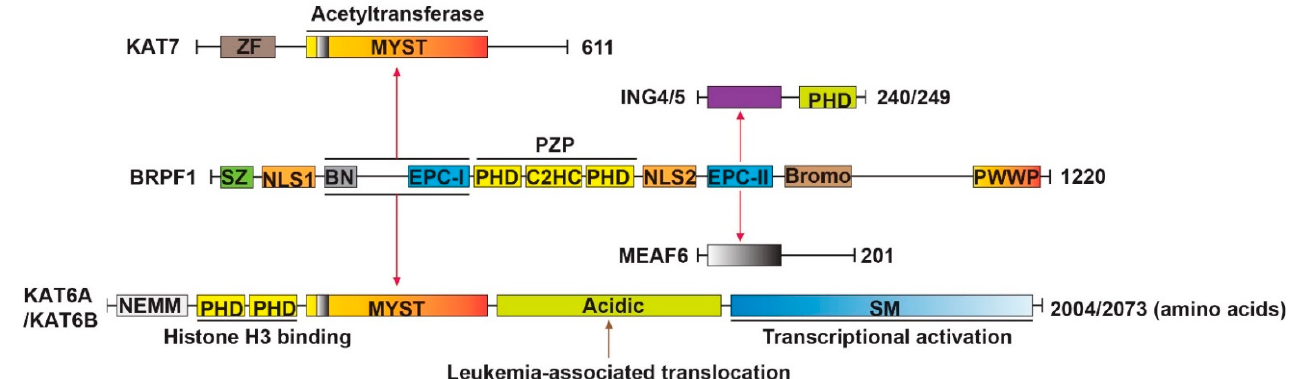
Figure 1. Molecular structure of the BRPF1-KAT6A/KAT6B complex. The figure illustrates how dif- ferent domains are involved in complex formation. BRPF1 contains SZ, NLS1, BN, EPC-I, PZP, NLS2, EPC-II, Bromo and PWWP domains. KAT6A/KAT6B contains NEMM, double PHD fingers, MYST, acidic and SM domains. KAT7 contains a ZF, MYST and a serine-rich domain (not depicted here). ING4/5 have a C-terminal PHD domain. BRPF1, KAT6A/KAT6B and KAT7 are 1220, 2004/2073 and 611 amino acids long, respectively. EPC-I and BN domains are required for association with MYST. EPC-II takes part in the interaction with ING5 or ING4 and MEAF6. Red arrows indicate interaction between two domains. SZ, Sfp1-like zinc finger; NLS, nuclear localization signal; BN, BRPF-specific N-terminal; EPC, enhancer of polycomb; PZP, PHD–zinc knuckle–PHD; Bromo, bromodomain; PWWP, Pro-Trp-Trp-Pro containing domain; NEMM, N-terminal part of Enok, MOZ and MORF; MYST, members MOZ, Ybf2/Sas3, Sas2 and Tip60; SM, serine/methionine-rich; ZF, zinc finger.